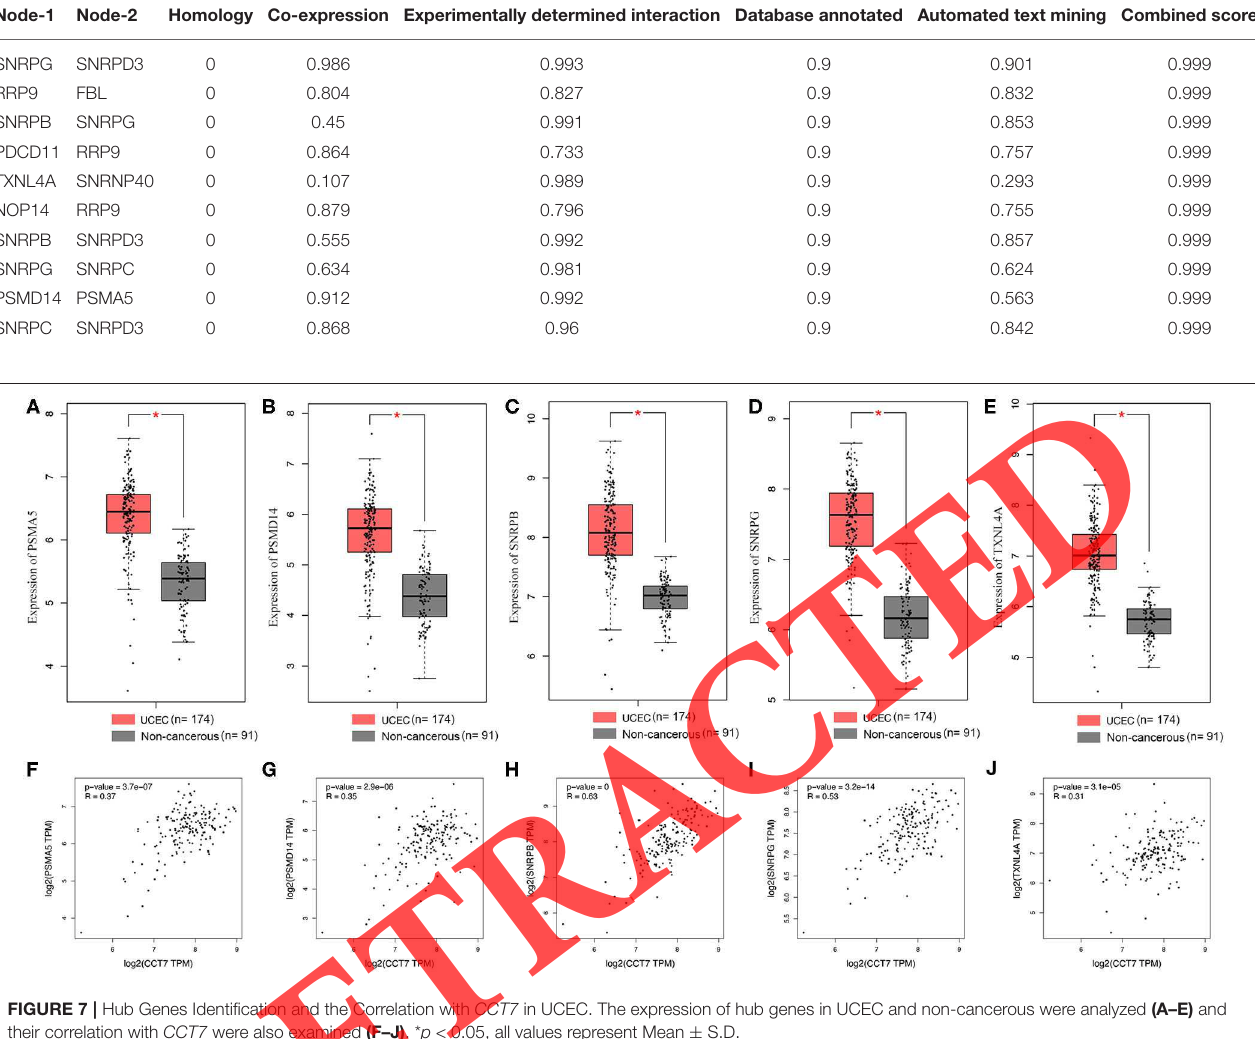
FIGURE 7 | Hub Genes Identification and the Correlation with CCT7 in UCEC. The expression of hub genes in UCEC and non-cancerous were analyzed (A–E) and their correlation with CCT7 were also examined (F–J) . * p < 0.05, all values represent Mean ± S.D.